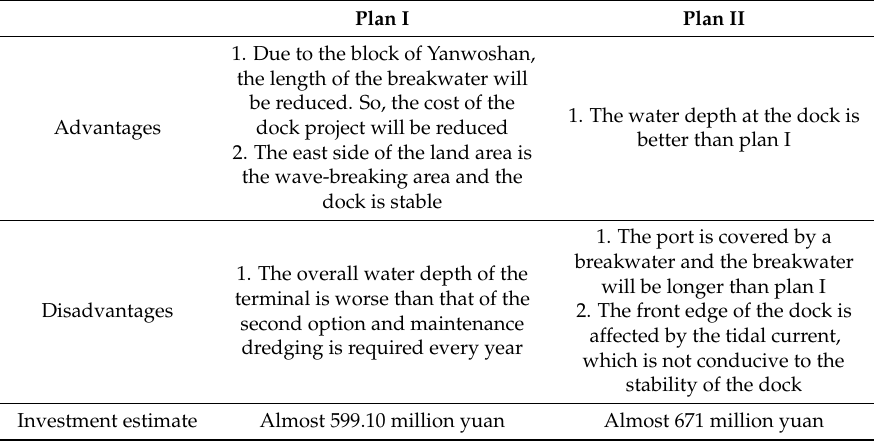
Table 7. The advantages and disadvantages of choosing plan I or plan Table 6. Cross flow speed statistics after engineering.